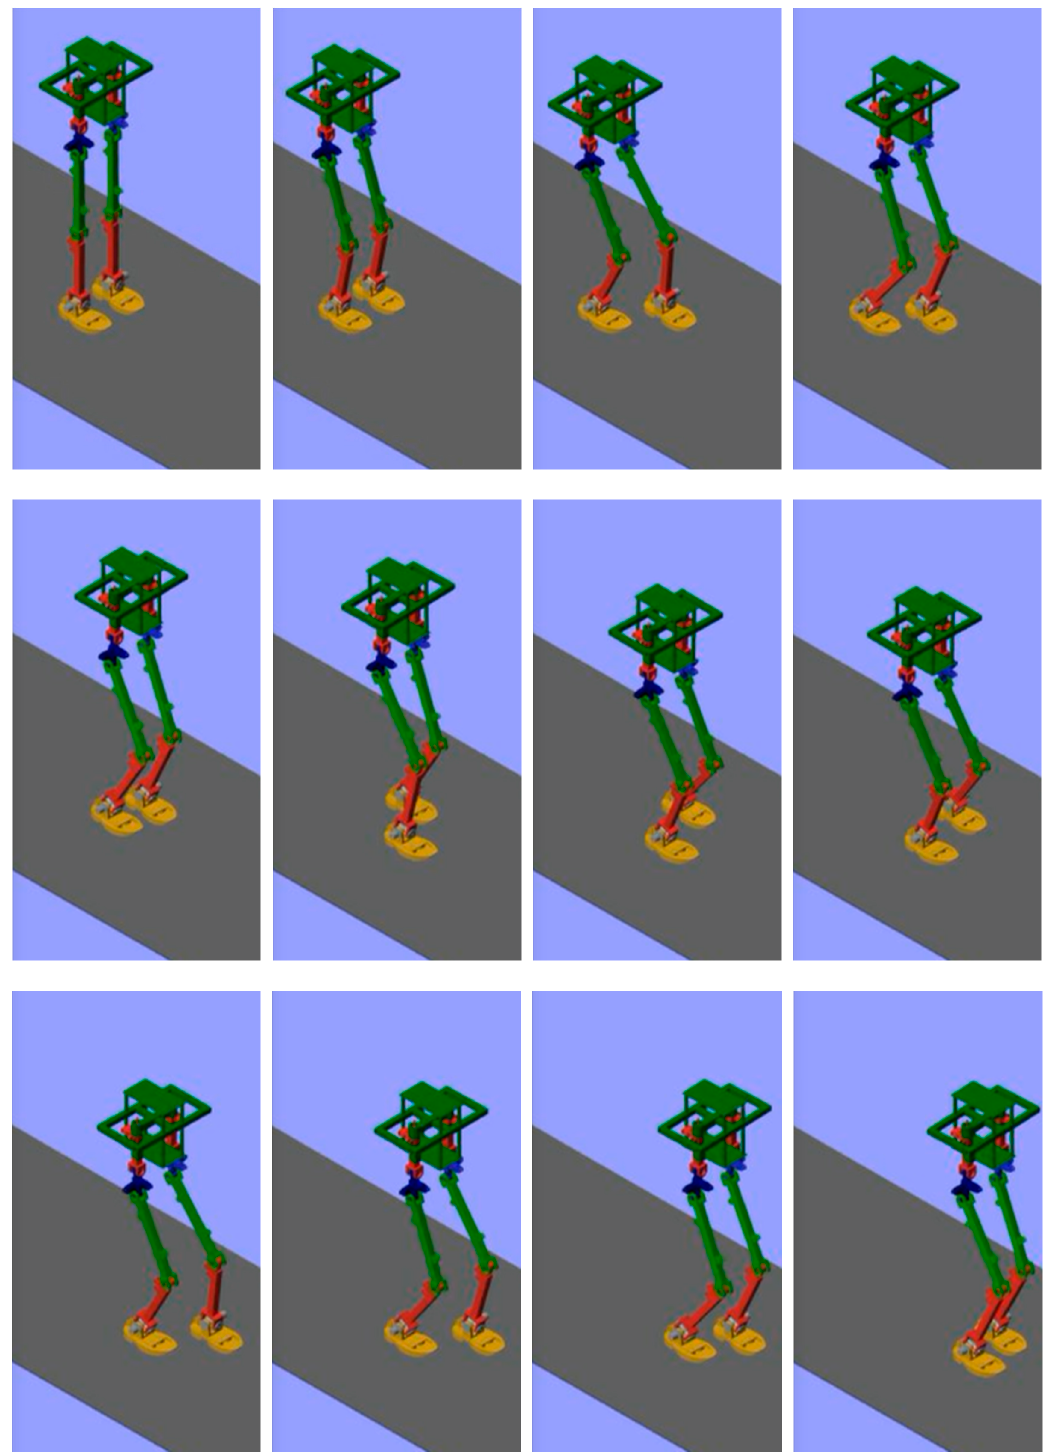
Figure 17. Simulation walking sequence.